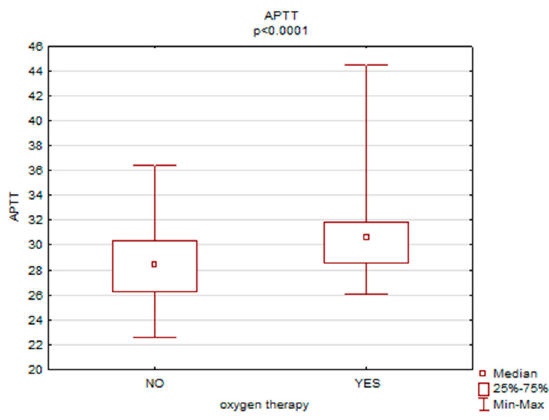
Figure 3. The necessity of oxygen therapy versus APTT levels.